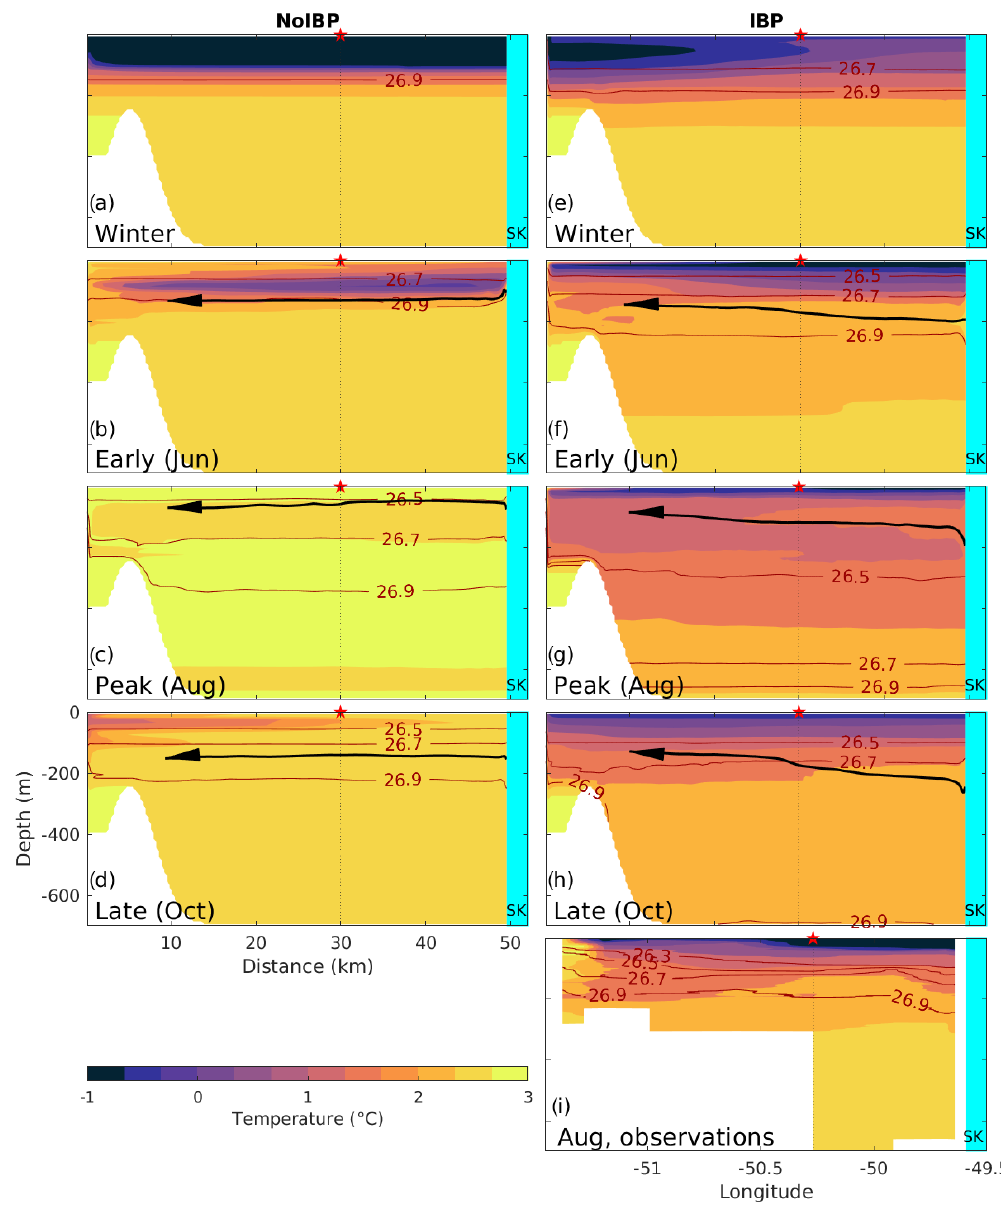
Figure 3. Along-fjord temperature sections of Ilulissat Icefjord with icebergs ( e–h , IBP) and without icebergs ( a–d , NoIBP), for the winter (March), early season (June), peak summer (August) and late season (October), as a snapshot along the centreline of the fjord. (i) Observed temperature section from XCTD data in August 2014 (Beaird et al., 2017), interpolated from XCTD locations marked in Fig. 1. Red contours mark the isopycnals of 26.3, 26.5, 26.7 and 26.9kgm − 3 . Black arrows indicate the centreline of the outflow of glacially modified water from the plume (see also Fig.